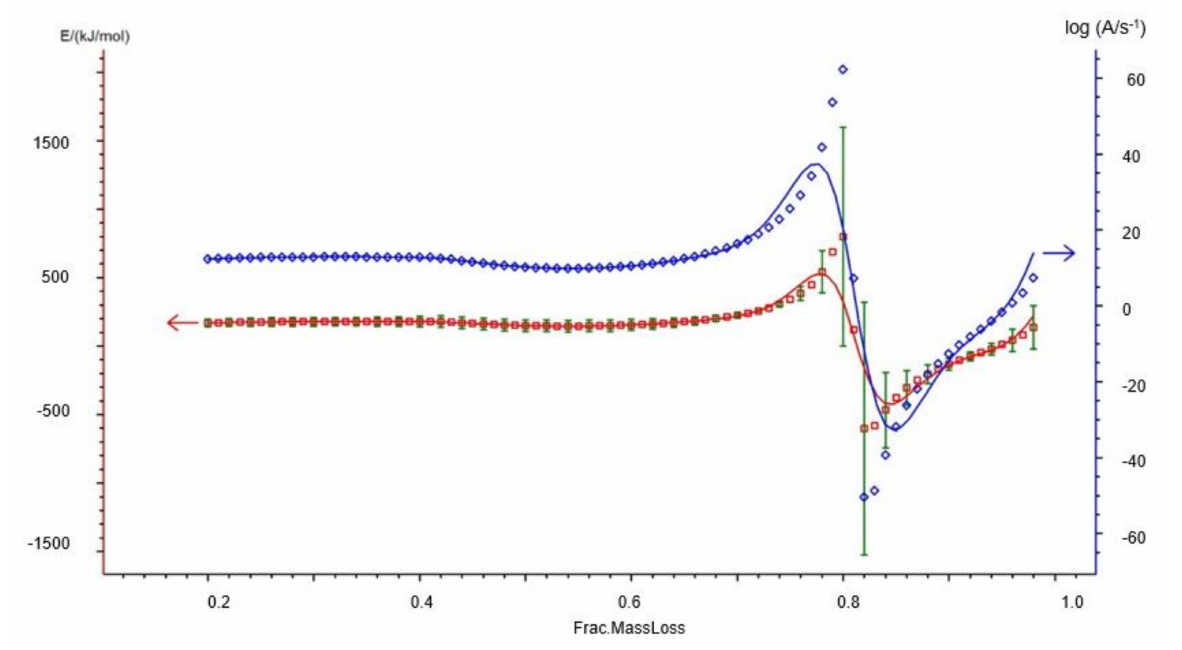
Figure A4. Plot of logarithm dx/dt as a function of reciprocal of temperature by Friedman method for sewage sludge. Red